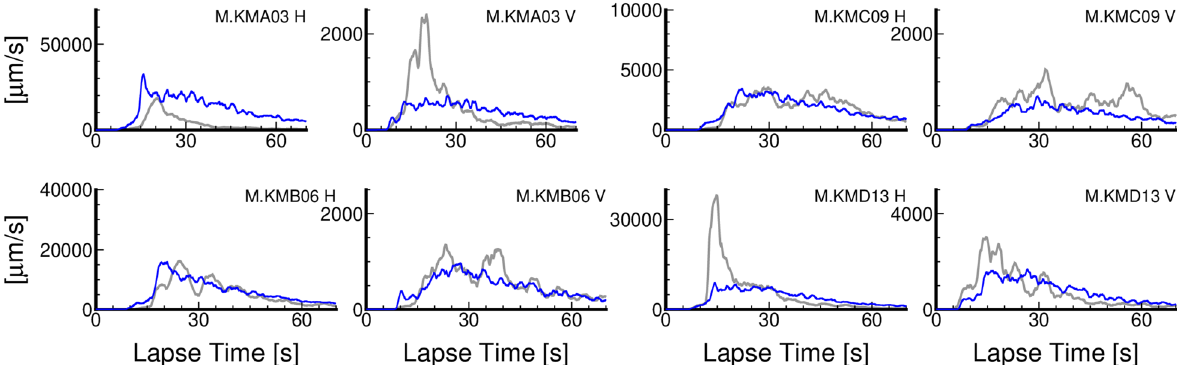
Fig. 13 Comparisons of observed and simulated envelopes for the frequency range of 2.0–4.0 Hz. Gray and blue lines represent observed and simulated envelopes, respectively. Station locations are given in Fig. 11a. The simulation results were normalized by the horizontal S max amplitude at N.KISF